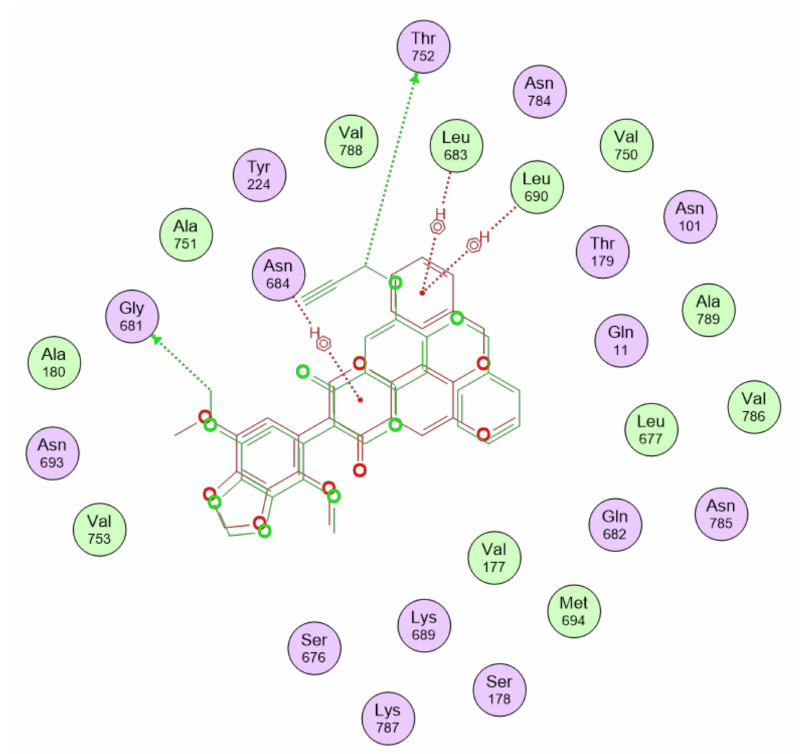
Figure 8. Binding interactions of gatastatin, represented in red, and gatastatin G2, shown in green, with the α - β III isotype structural model. Table 6. Binding scores of the analyzed ligands resulting from docking simulations in the GTP site and in the putative colchicine site of γ